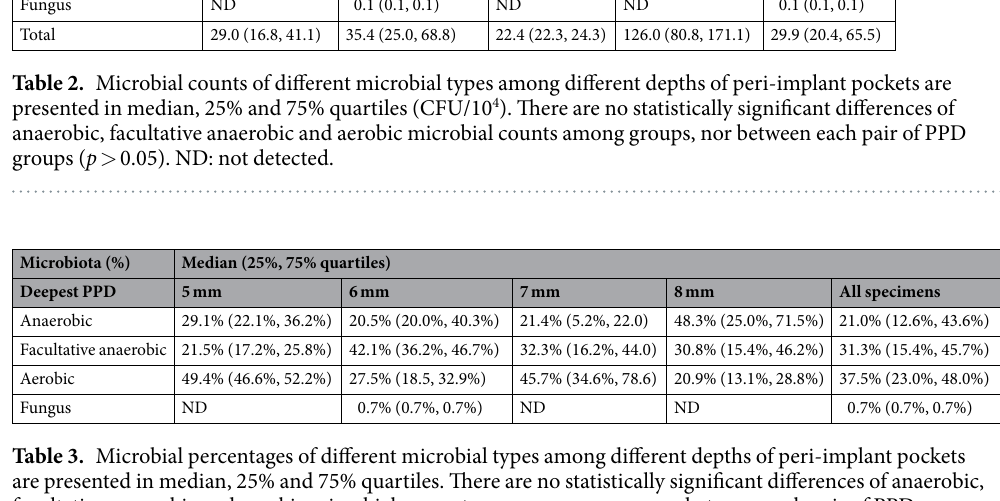
Table 3. Microbial percentages of different microbial types among different depths of peri-implant pockets are presented in median, 25% and 75% quartiles. There are no statistically significant differences of anaerobic, facultative anaerobic and aerobic microbial percentages among groups, nor between each pair of PPD groups ( p > 0.05). ND: not